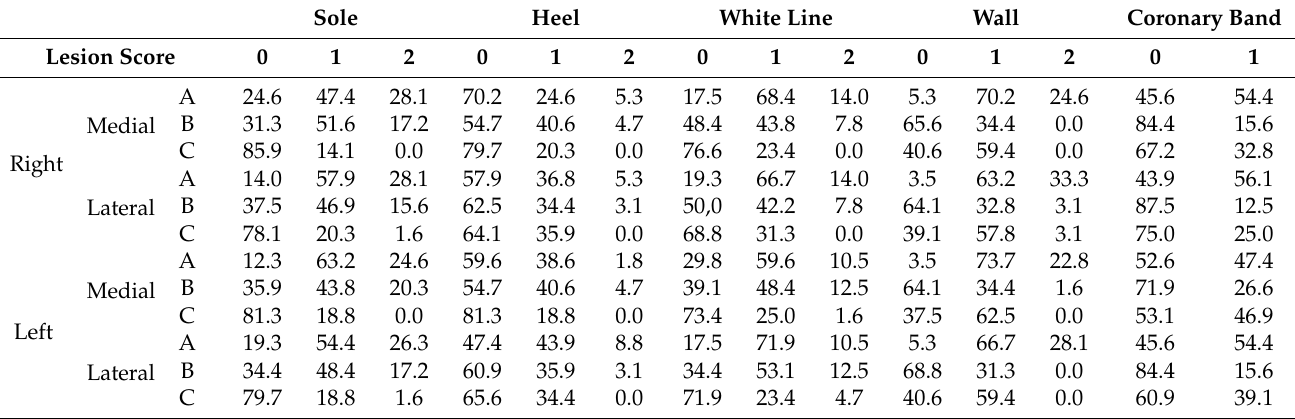
Table 4. Percentage of medial and lateral claws of front feet in each of the 3 classes of lesion scores on five foot sites (sole, heel, white line, wall, coronary band) in slaughtered sows from three pig farms (A, B, C). The sows of each farm belonged to different genetic lines (Farm A: PIC; Farm B: Danbred; Farm C: Topigs).